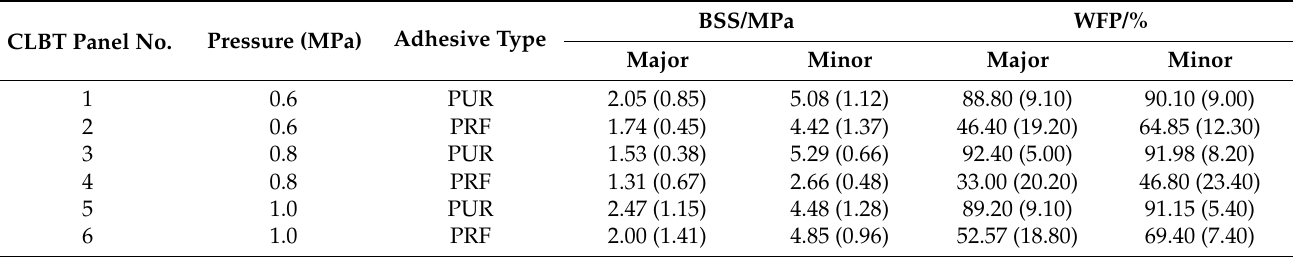
Table 3. The mean values of bonding shear strength and wood failure percentage of CLBT.